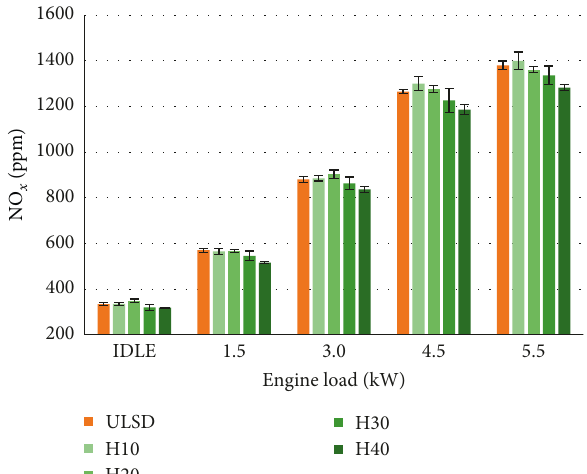
Figure 11: Particulate matter emissions for ULSD and HUCO blends for all loads.